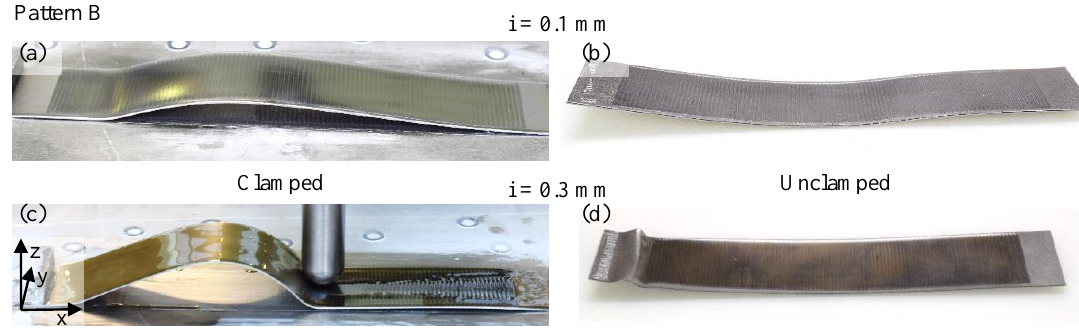
Figure 7. Pattern B: experimental results before (left, ( a ) and ( c )) and after (right, ( b ) and ( d )) unclamping for different intrusion depths i = 0.1 mm (top, ( a ) and ( b )) and i = 0.3 mm (bottom, ( c ) and ( d )).